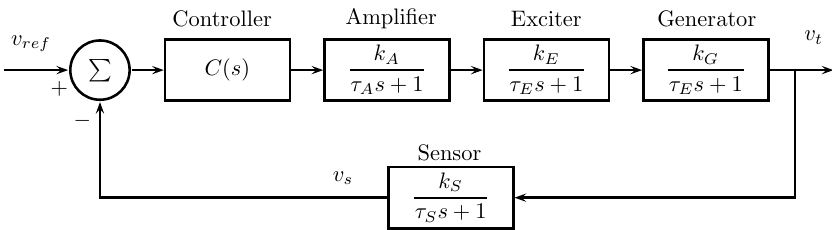
Figure 3. Block diagram of the AVR